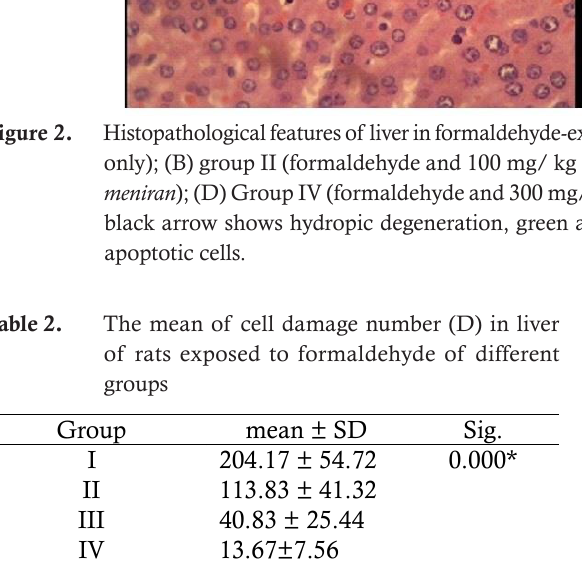
(*) a difference among groups based on Kruskal Wallis test